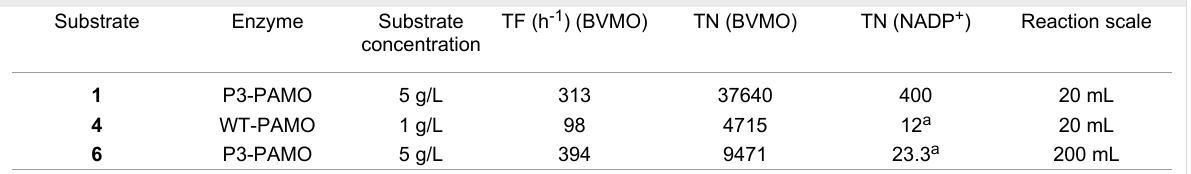
Table 2: Catalytic efficiency of WT- and P3-PAMO in in vitro catalysis with two-liquid phases. TF: Turnover frequency; TN: Total turnover number. Substrate